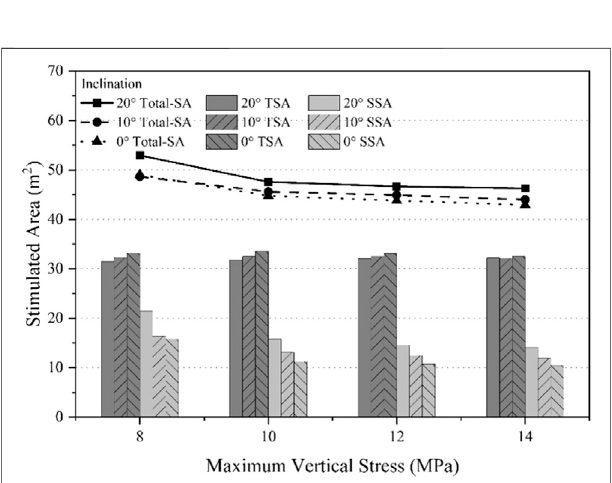
FIGURE7| Effectofcaprockverticaldifferentialstressandinclination on tension and shear stimulated areas.